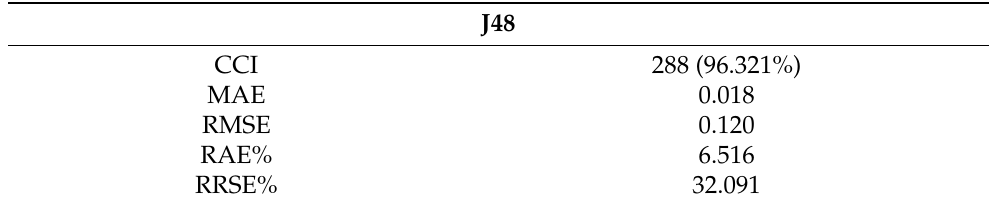
Table 21. CCI and Error Rates details achieved via J48.